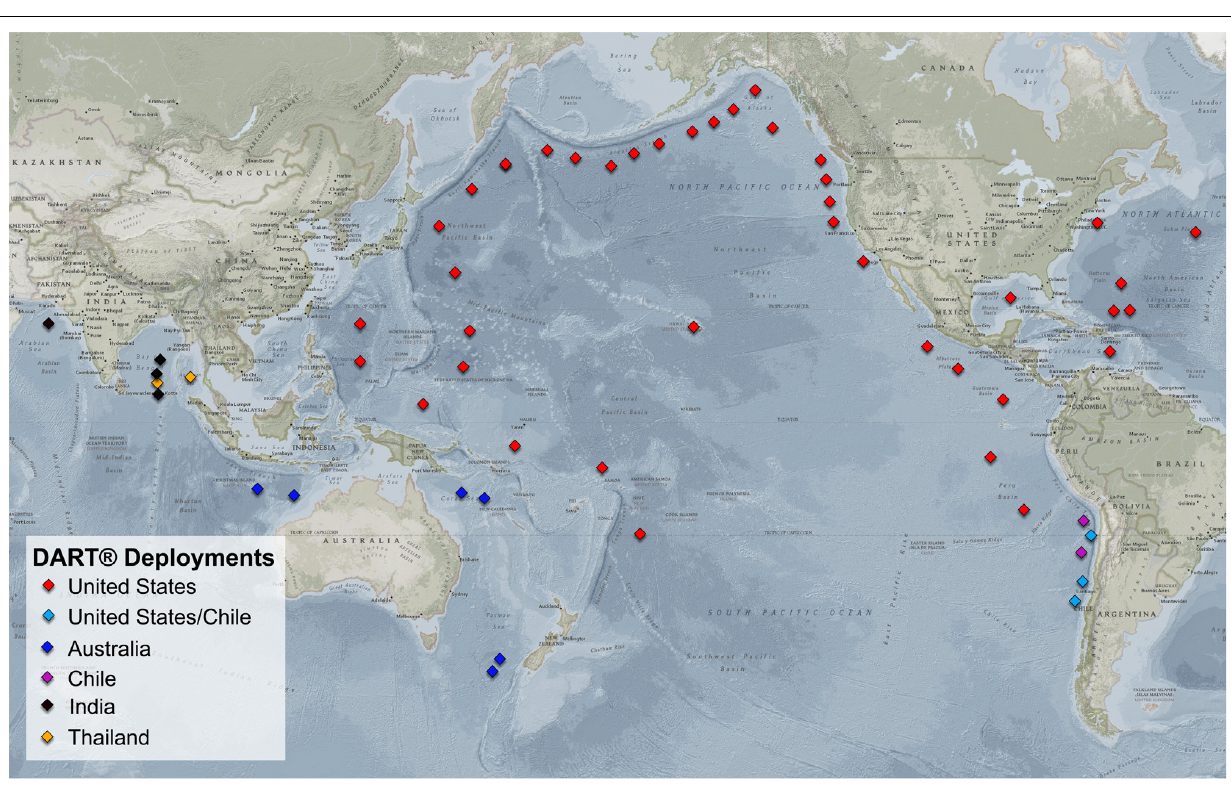
FIGURE 3 | This map provides a visual summary of the DART system network as of November 2018. The DART network includes United States systems as well as systems owned and operated by Australia, Chile, India, and Thailand. Source: Adapted from NOAA National Centers for Environmental